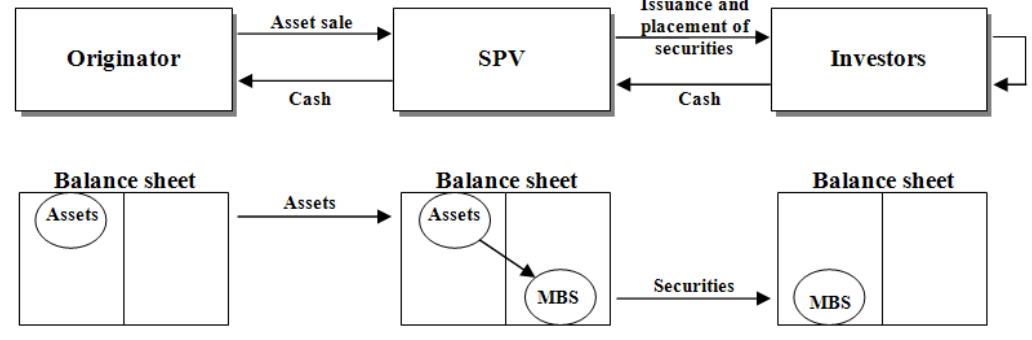
Fig. 1. Financial flows in a securitization